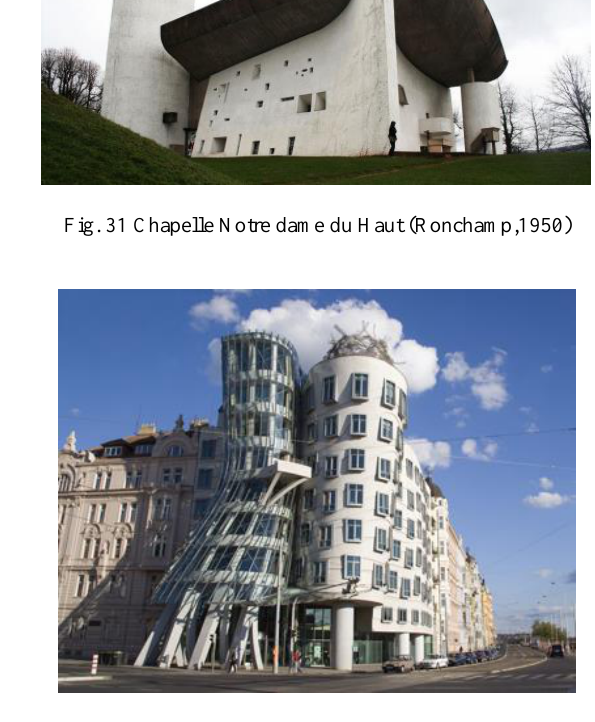
Fig. 32 Dancing House (Prague, 1996